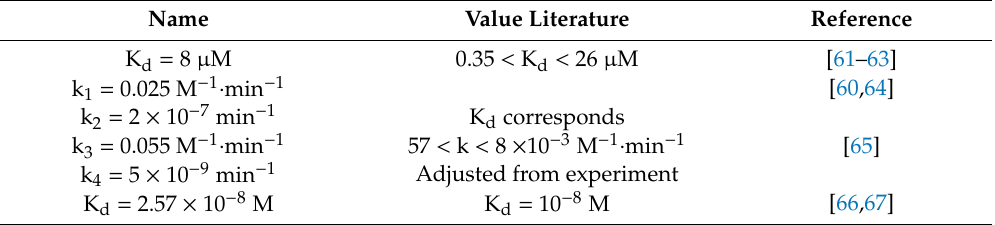
Table 2. Di ff erent kinetic constants values used in the simulation, values from the literature.